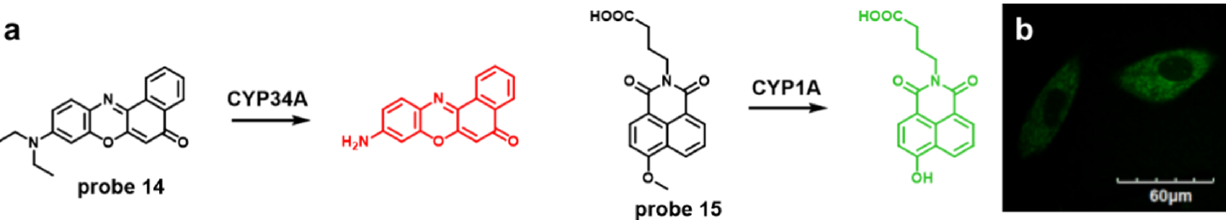
Figure 5. ( a ) Chemical structures of probes 14 and 15 against CYPs; ( b ) Confocal fluorescence images of A549 cells. Cells incubated with probe 15 (50 μ M) for 1h. The fluorescence images were acquired using 405 nm excitation and fluorescent emission windows: green emission channel. (Reprinted with permission from [46]. Copyright 2015 American Chemical Society.).